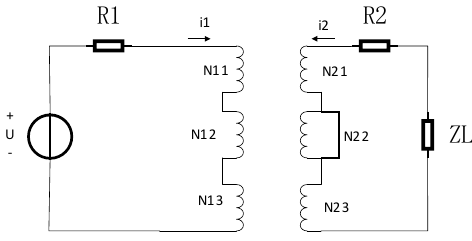
Figure 2. Simulation circuit.